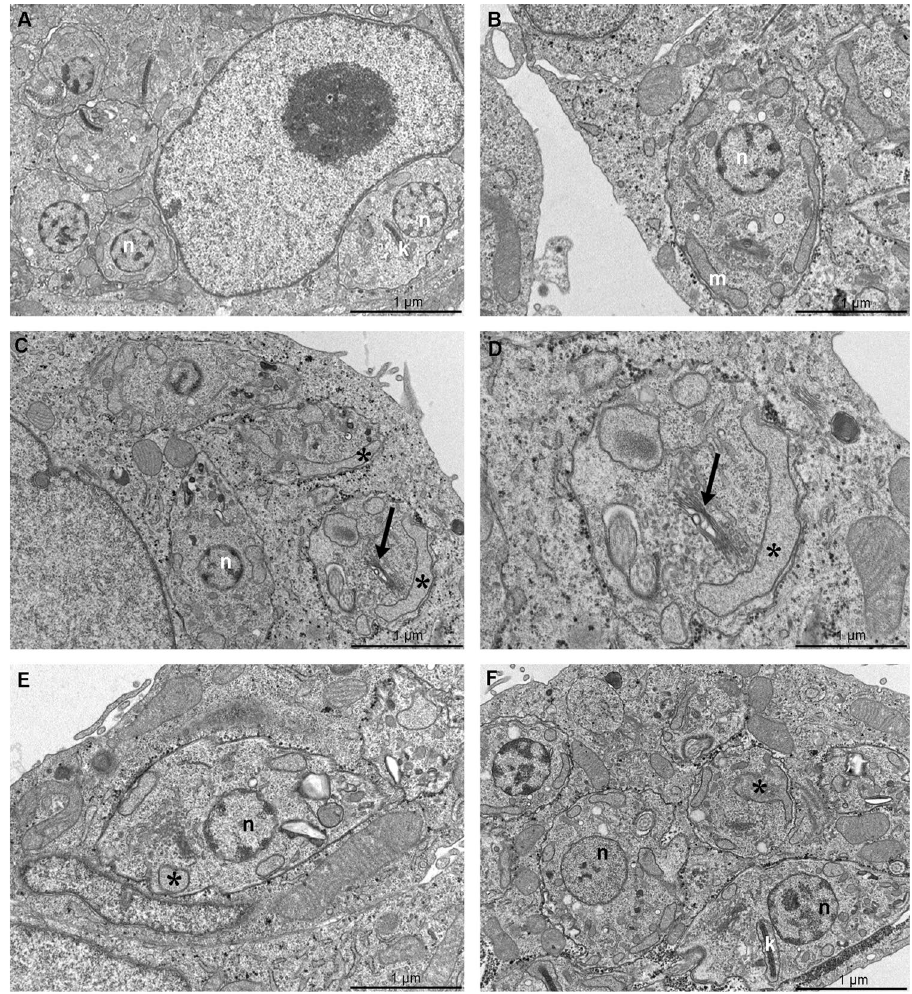
Figure 8. Transmission electron microscopy of T. cruzi amastigotes in the presence of FEX for 72 h. ( A ) Non-treated amastigotes present the nucleus (n) with the condensed heterochromatin, a single branched mitochondrion (m), and a bar-shaped kinetoplast (k). ( B ) Five-hundred nanomolar did not promote ultrastructural modifications on amastigotes. ( C , D ) One micromolar caused Golgi disorganization (black arrow) and mitochondrial swelling (asterisk). ( E , F ) Amastigotes treated with 5 µM presented mitochondrial swelling